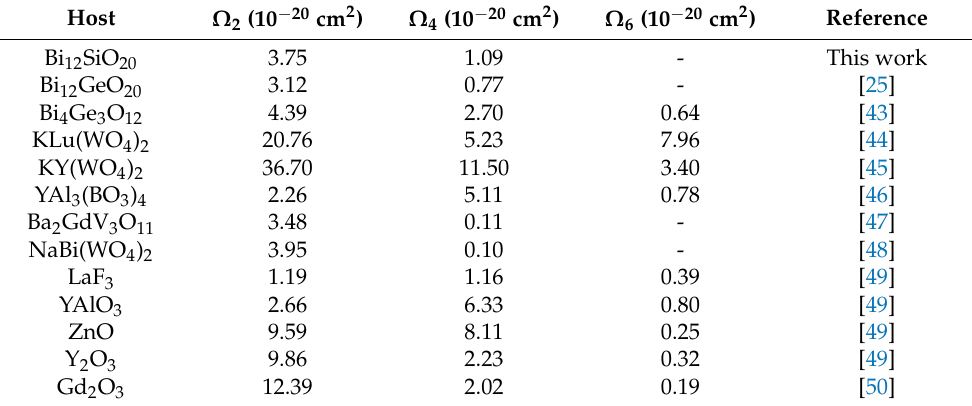
Table 2. The comparison of the Judd–Ofelt parameters between different europium-doped hosts.